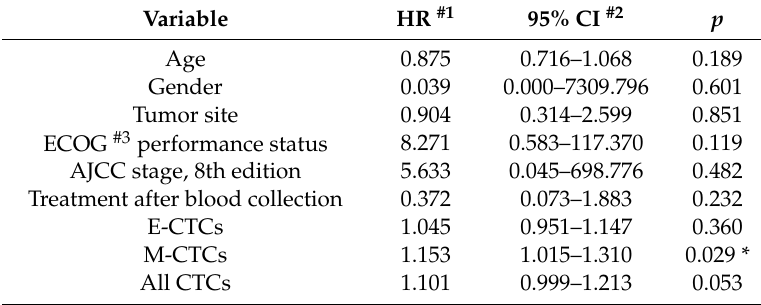
Table 3. Cox regression (univariate) analyses for progression-free survival